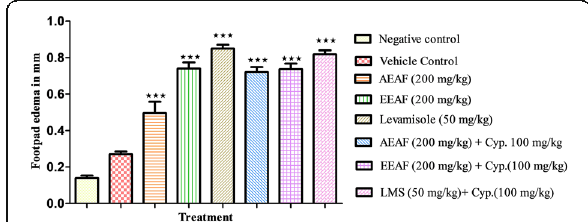
Fig. 8 Effect of AEAF and EEAF on Primary HA titre. Results were expressed as mean ± SEM, ( n = 6). Statistical analysis was performed with one-way analysis of variance (ANOVA) followed by Tukey- Kramer multiple comparison test. # P < 0.05, ## P < 0.01 as compared with NC. P value less than < 0.05 was considered to be statistically significant. * P < 0.05, ** P < 0.01 and *** P < 0.001, when compared